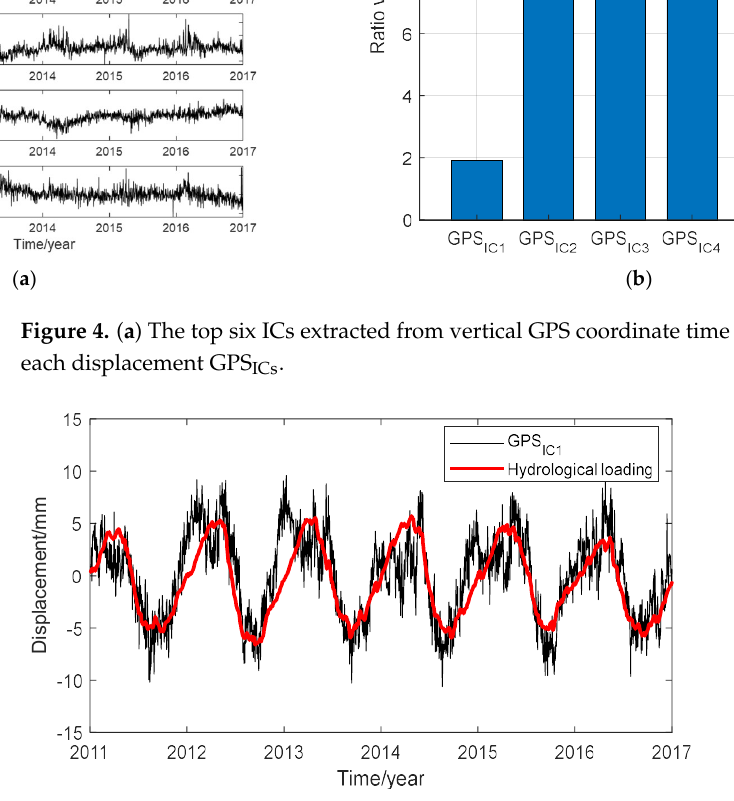
Figure 4. ( a ) The top six ICs extracted from vertical GPS coordinate time series; ( b ) the ratio value of each displacement GPS ICs.